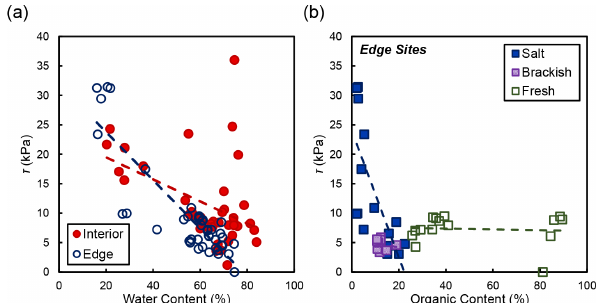
Figure 6. (a) Shear strength ( τ ) compared to water content at con- current depths in the soil profile. Only the relationship between water content and shear strength at the marsh edge was signif- icant ( R 2 = 0 . 76, p = 5 . 72 × 10 − 14 ). (b) Shear strength and or- ganic content at concurrent depths in the soil profile grouped by salinity type. The relationships between shear strength and organic content are as follows: salt marshes (Goodwin Islands and Catlett Islands; R 2 = 0 . 52; p = 0 . 001), brackish marsh (Taskinas Creek; R 2 = 0 . 04; p = 0 . 596), and freshwater marsh (Sweet Hall Marsh and the Pamunkey Indian Reservation; R 2 = 0 . 01; p = 0 .